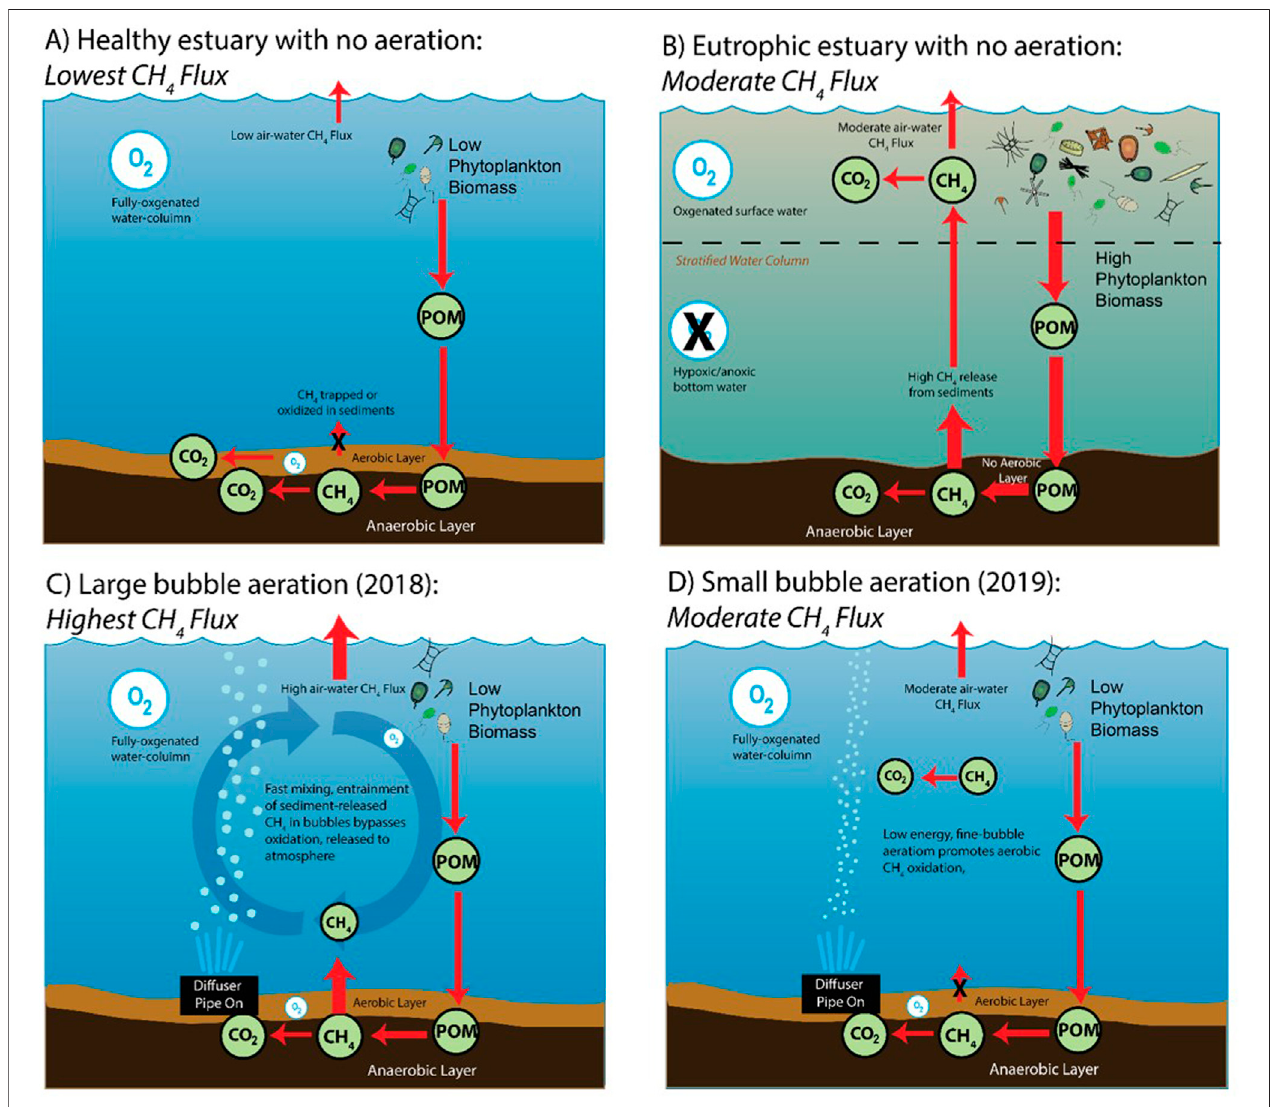
FIGURE 1 | Conceptual diagrams of methane dynamics in estuarine waters. With no aeration, (A) the lowest methane fl ux comes from a water column that is well oxygenated and (B) there is a moderate fl ux when waters are eutrophic. When aerated, the methane fl ux is (C) highest when there are large bubbles and (D) moderate when there are small